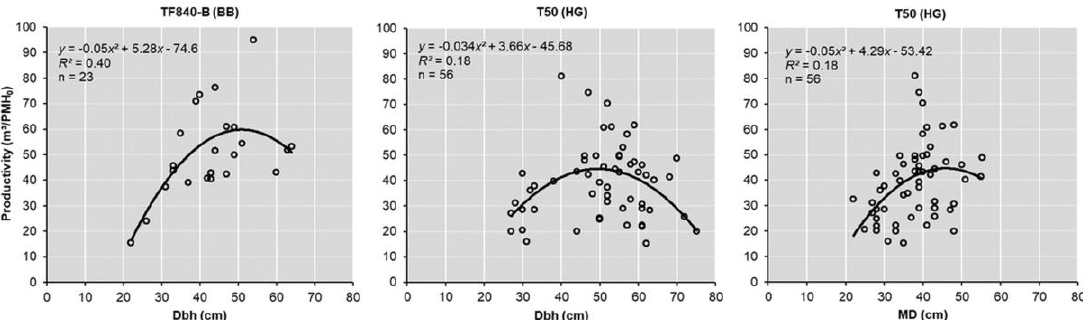
Figure 8. Productivity curves (2nd degree polynomial regressions) for the two machines (case studies) in the motor-manual (MM) group. Two plots are shown for the T50 where the abscissa is presented as dbh of harvested trees or mid diameter (MD) of the largest processed log by the machine.